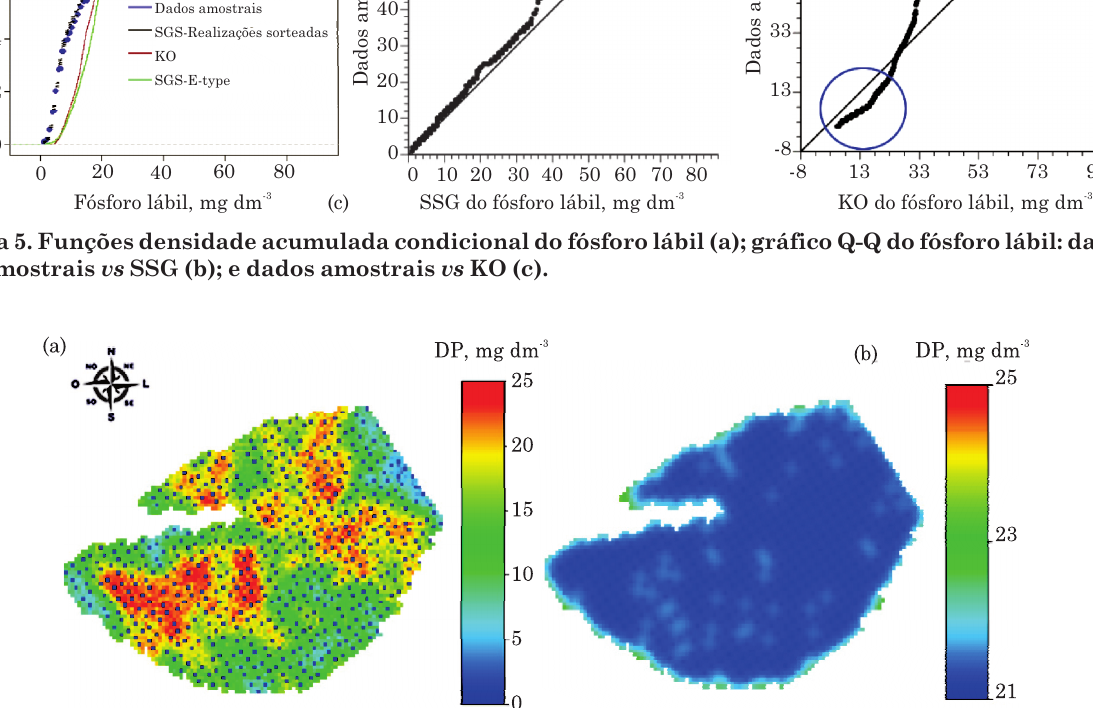
Figura 6. Mapas de desvio-padrão (DP) para os teores de fósforo lábil, gerados a partir da SSG (a) e KO